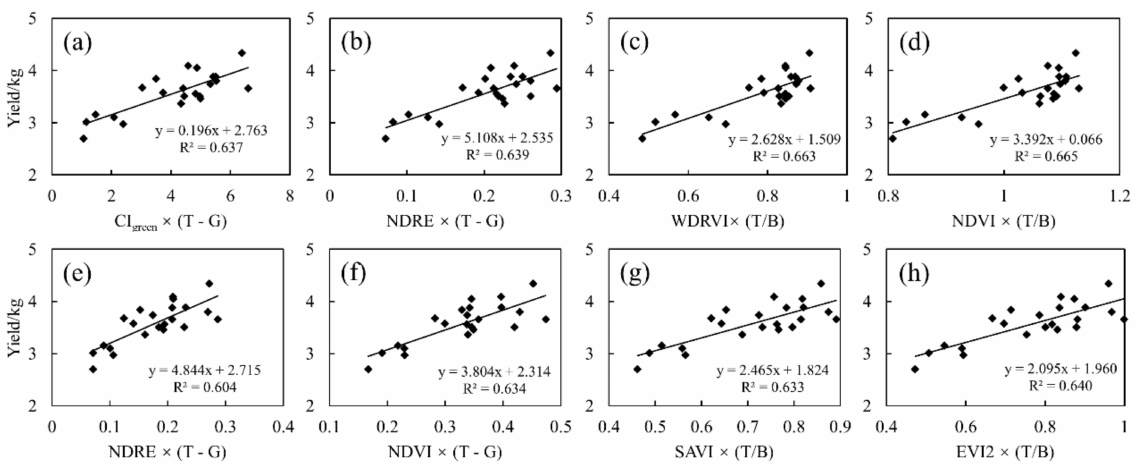
Figure 10. Well-performing yield-estimation models incorporating TCT combination parameters and VIs at different stages: ( a – d ) booting stage; ( e – h ) heading stage. At length, the LOO-CV method was used to verify the model of the rice-yield estima- tion at the heading stage, and the results are shown in Figure 11. The model estimation errors of the NDRE × (T − G), NDVI × (T − G), SAVI × (T/B), and EVI2 × (T/B) were less than 7%.